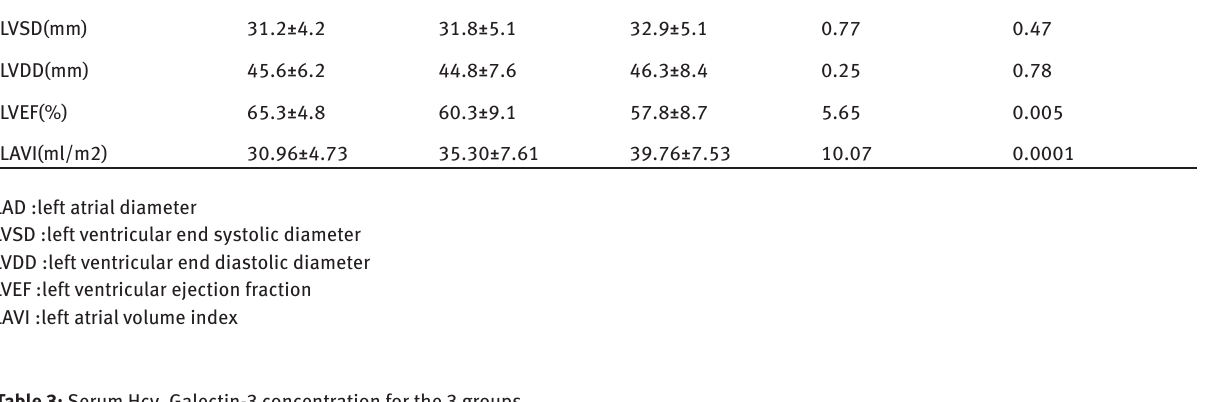
Table 3: Serum Hcy, Galectin-3 concentration for the 3 groups.